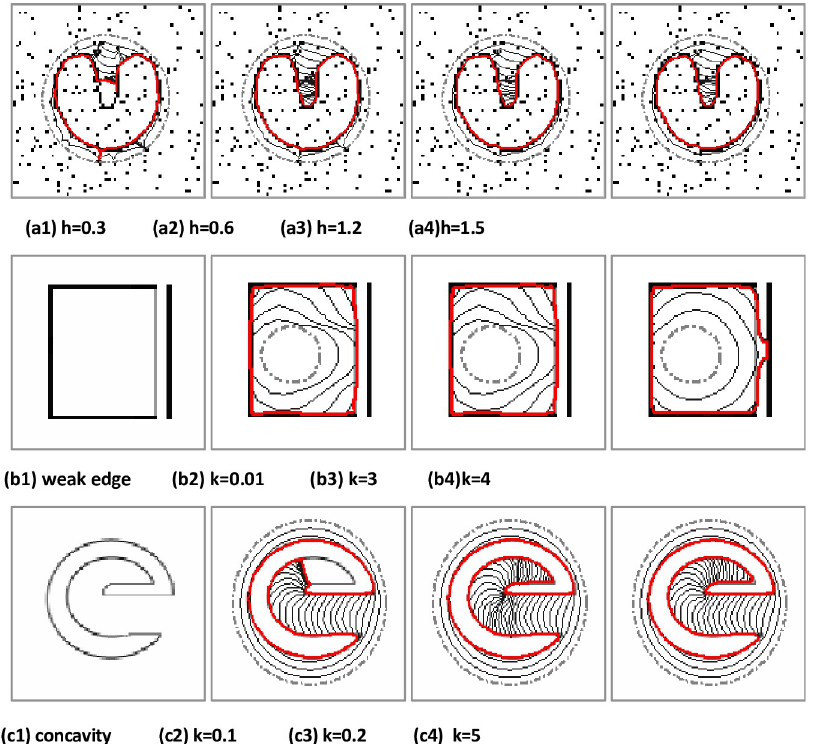
Fig 1. Analysis of parameter sensitivity. The gray dashed, black and red solid lines represent initialization, curve evolution and final result, respectively.